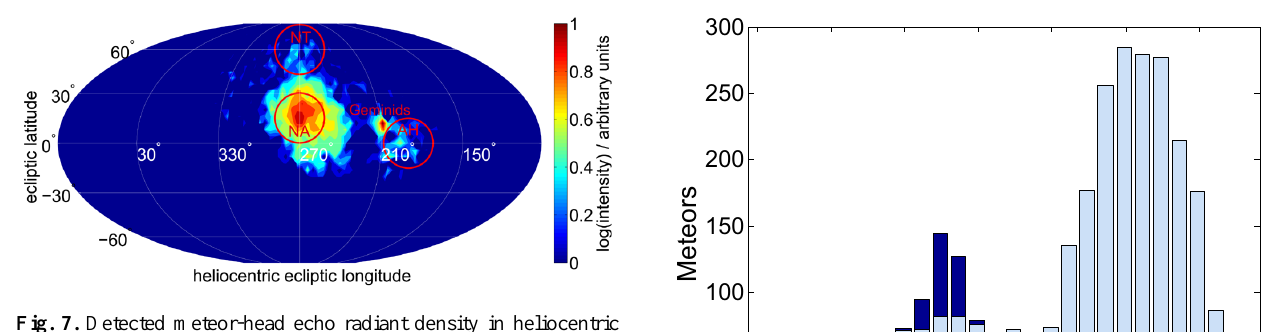
Fig. 7. Detected meteor-head echo radiant density in heliocentric coordinates, North Apex (NA), Antihelion (AH), North Toroidal (NT).